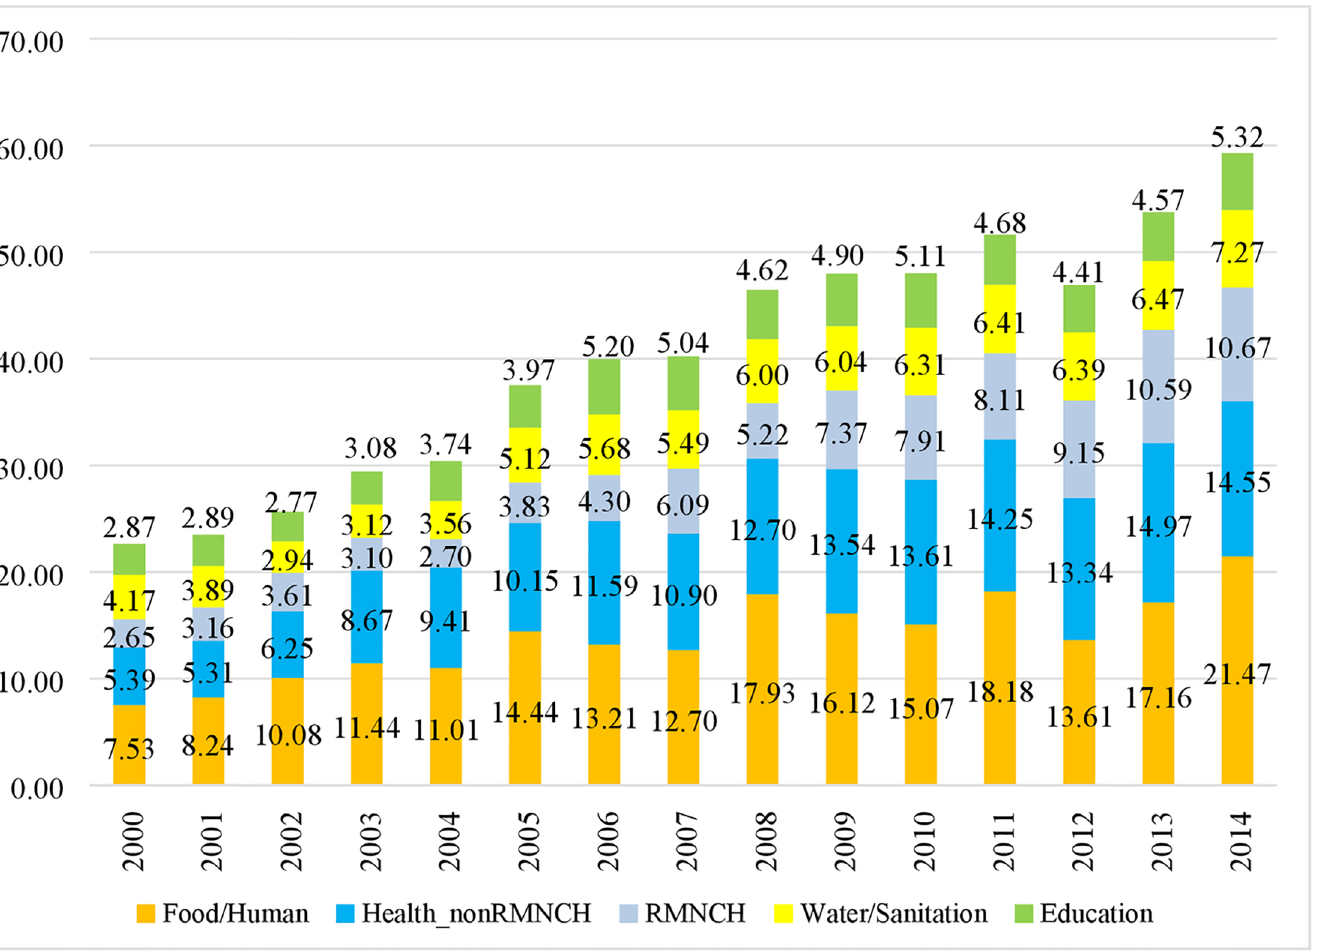
Fig 3. Upper-bound estimatesof aid disbursed to RMNCH, health_non-RMNCH, food, water.